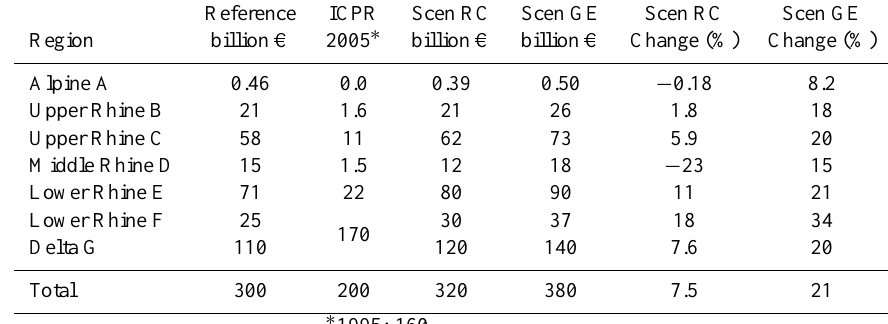
Table 4. Expected damage for different regions in 2000 and 2030 (at 2000 prices) ( ∗ the estimate of the ICPR, 2005a).